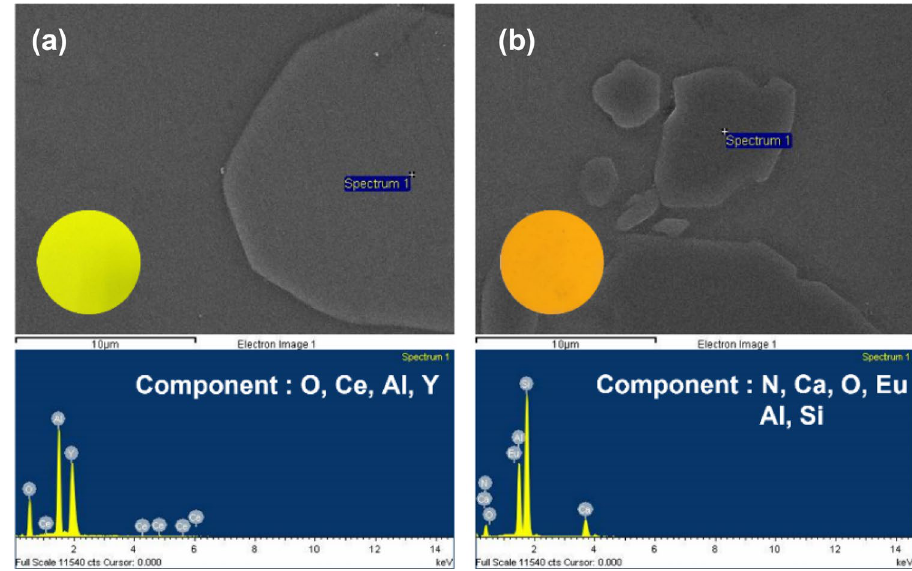
Figure 8. Point EDS results of yellow and amber PiGs, respectively.